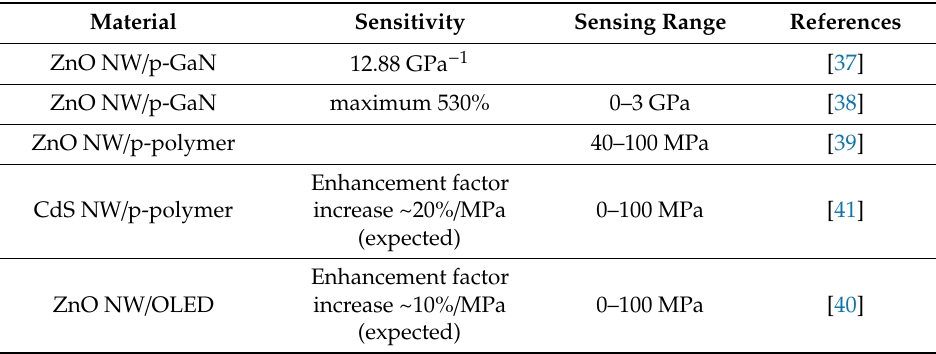
Table 6. Pressure sensors based on the piezophototronic e ff